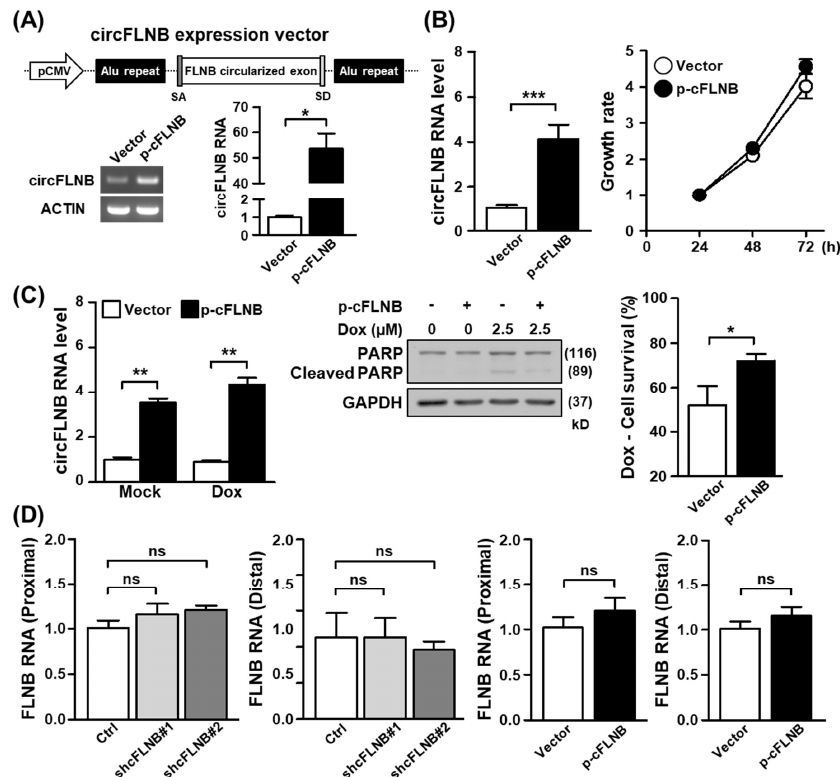
Figure 5. The circFLNB promotes cell survival under apoptotic stress. ( A ) Ectopic expression construct of circFLNB (p-cFLNB) was established by sub-cloning the circularized exons of circFLNB together with the flanking Alu repeats into a CMV-driven expression vector backbone. Overexpression efficacy in cells was monitored by end-point PCR and qPCR assays. ( B ) SAS cells were infected with control and p-cFLNB constructs, and subsequently analyzed for circFLNB expression and proliferation rate by qPCR and MTT methods, respectively. ( C ) Control and circFLNB overexpression cells were treated with 2.5 μM doxorubicin to induce cell death, and PARP protein expression/cleavage and cell survival were monitored as in Figure 4. ( D ) Expression levels of the parental FLNB gene in cells with circFLNB knockdown or overexpression was detected by qPCR assay, by using primers corresponding to FLNB transcript regions proximal or distal to the back-splicing junction. For statistical analyses shown in this figure: * p < 0.05; ** p < 0.01; *** p < 0.001.